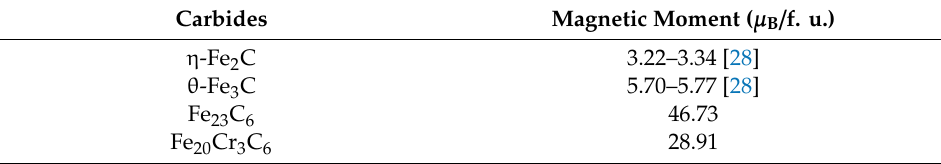
Table 3. Magnetic moments of η -Fe 2 C, θ -Fe 3 C, Fe 23 C 6 and Fe 20 Cr 3 C 6 ( µ B per formula).